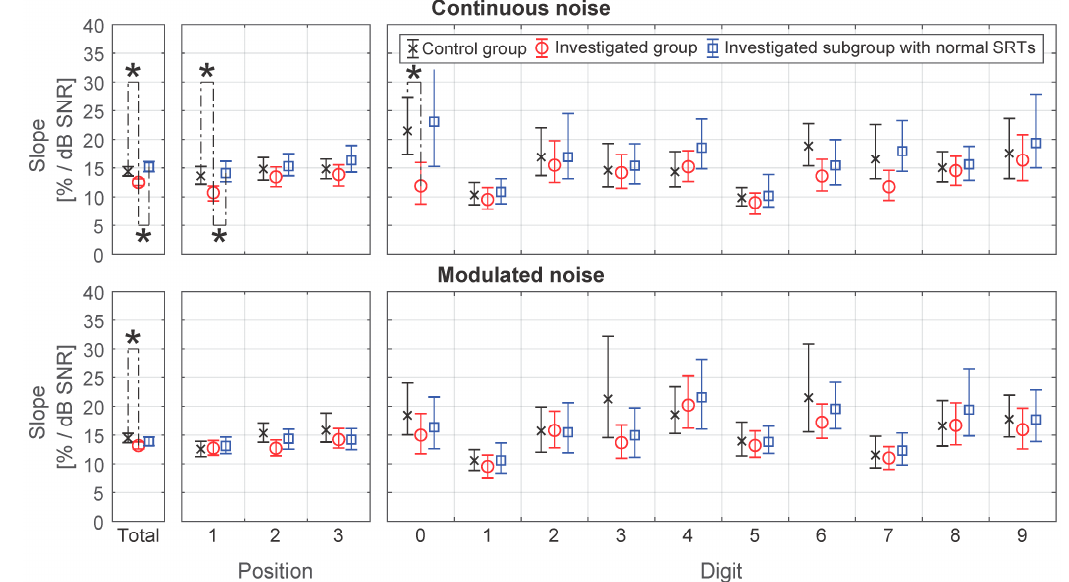
Figure 7. Position-specific and digit-specific slopes of the psychometric function for continuous and modulated noise. The 95% confidence intervals are marked by whiskers. Statistically significant differences at the level of p = 0.05 calculated applying Bonferroni correction for multiple comparisons were marked (*).